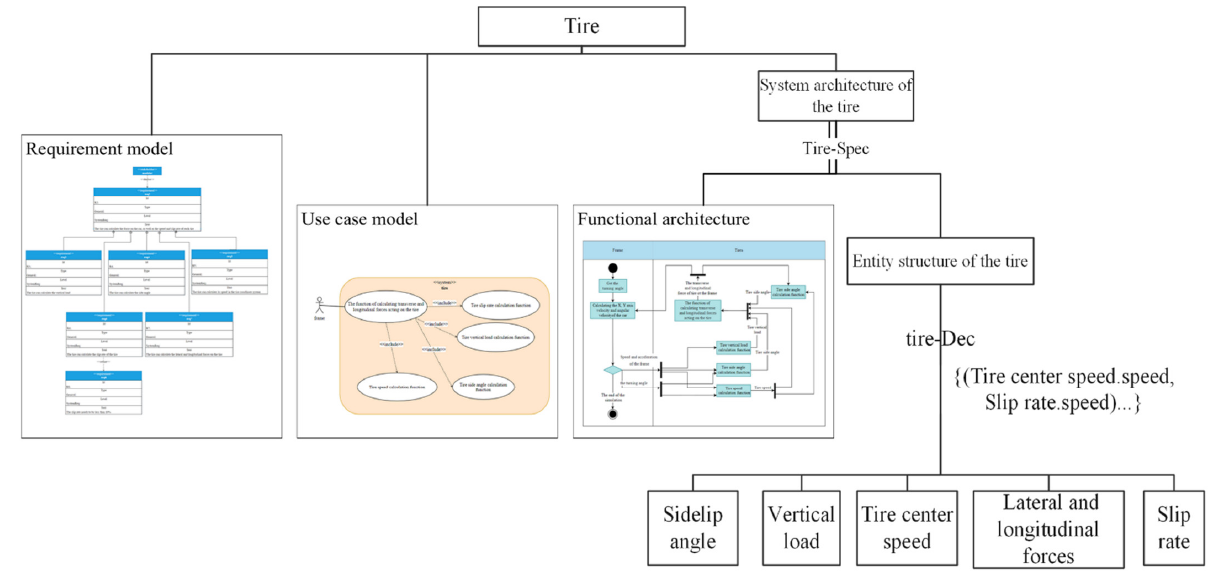
Figure 10. The SES-X model of the tires.